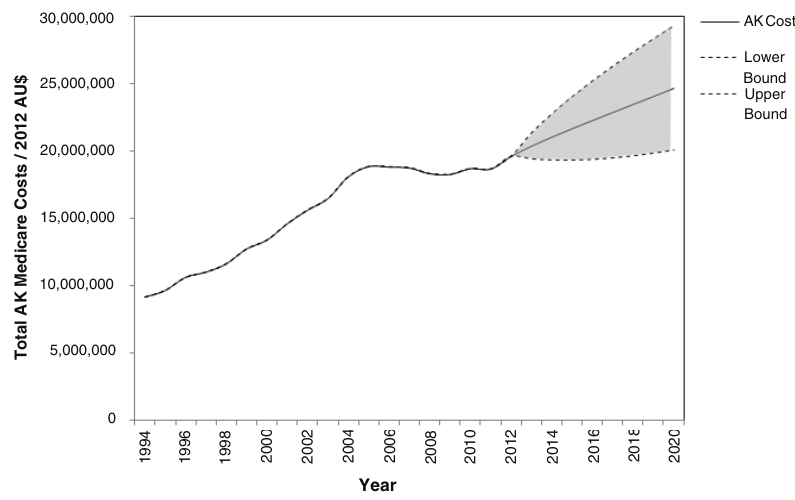
Figure 2. Total cost of AK treatments to Medicare in 2012 Australian dollars from the period of 1994–2020. Estimated costs with 95% CI from 2013–2020 is shaded in grey.